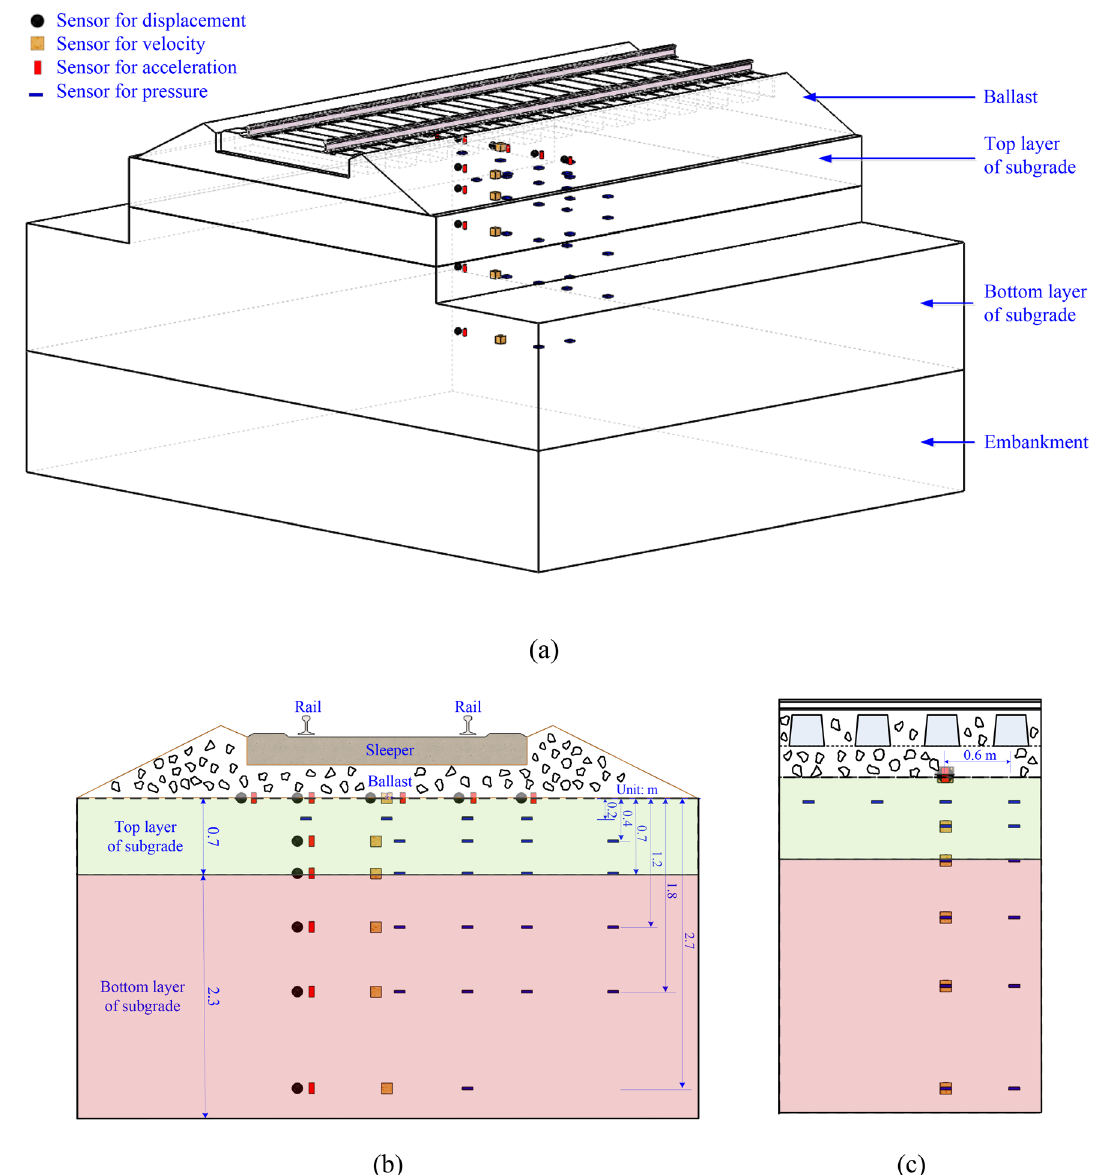
Fig. 4 Layout scheme of the sensors in subgrade at ballasted track section: a layout scheme; b front view; c side